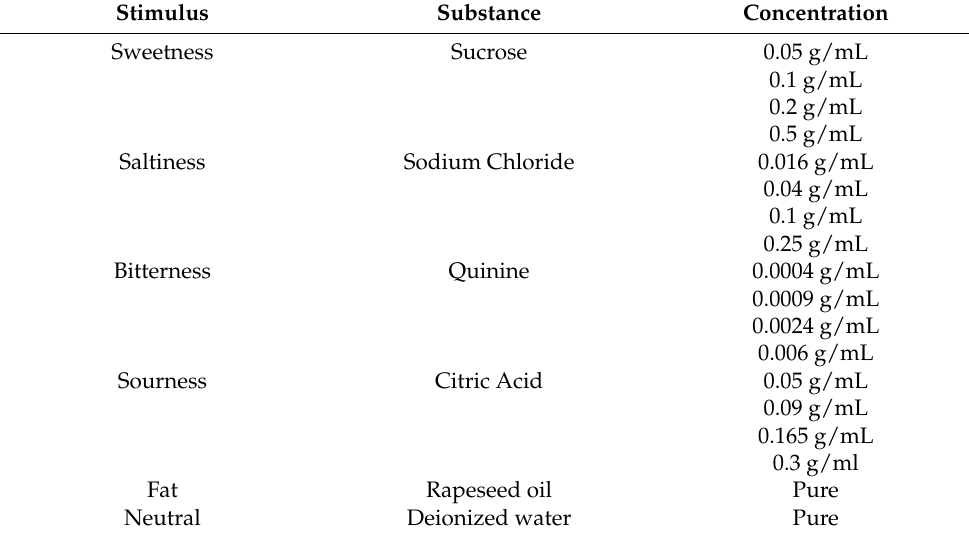
Table 1. Concentrations of taste